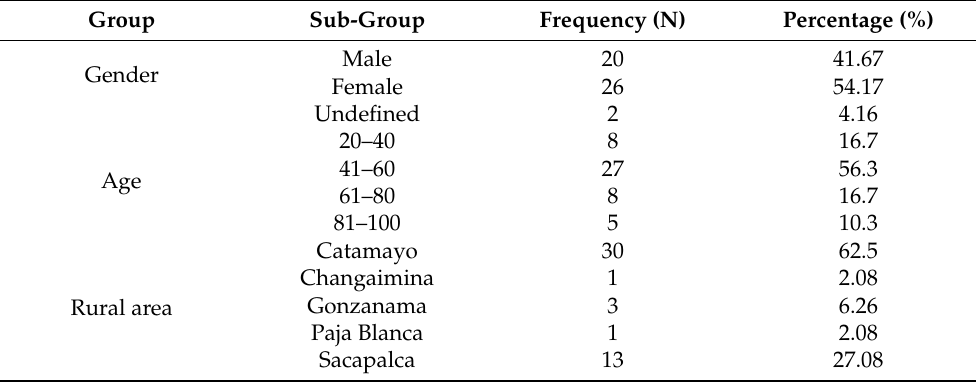
Table 2. Demographic characteristics of